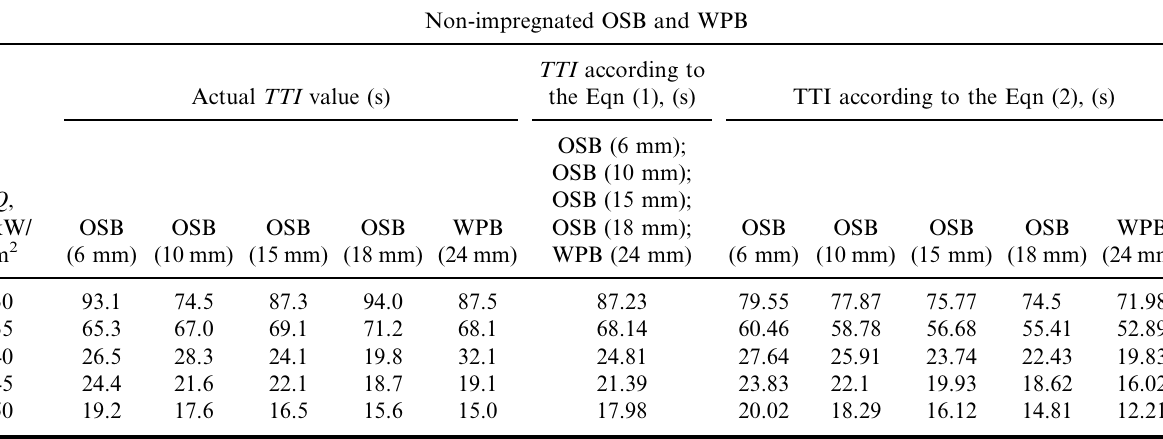
Table 5. Actual and forecasted values of TTI for non-impregnated OSB and WPB Non-impregnated OSB and WPB